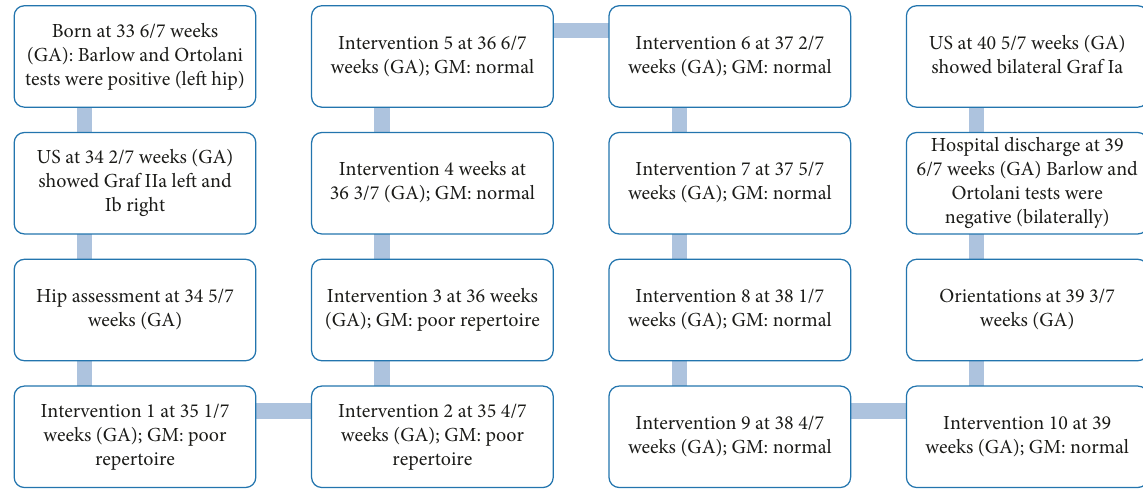
Figure 1: Timeline showing the main events during hospital stay. GA: gestational age.